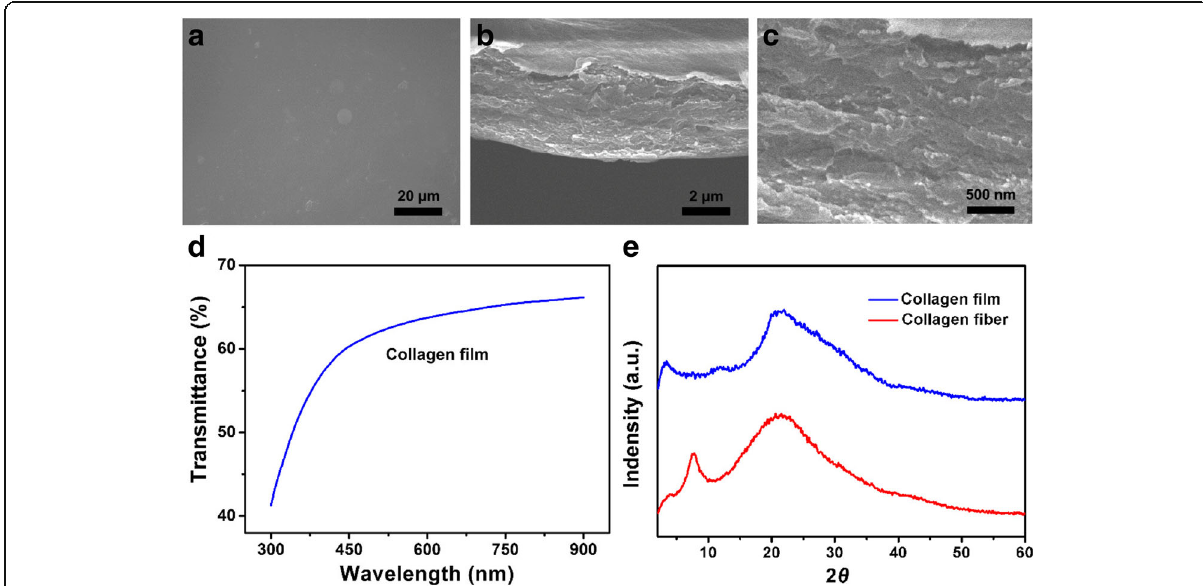
Fig. 2 Properties of the collagen film. a top-view and b cross-sectional view of the collagen film. c A magnified view of ( b ). d UV-vis